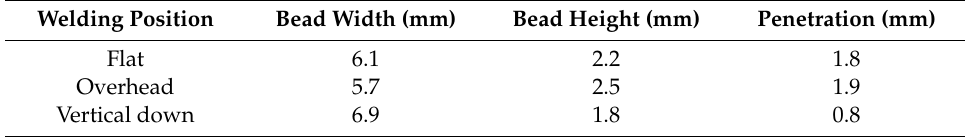
Figure 10. Short circuit transfer in vertical down position. Table 3. Experimental results of bead profiles in various welding